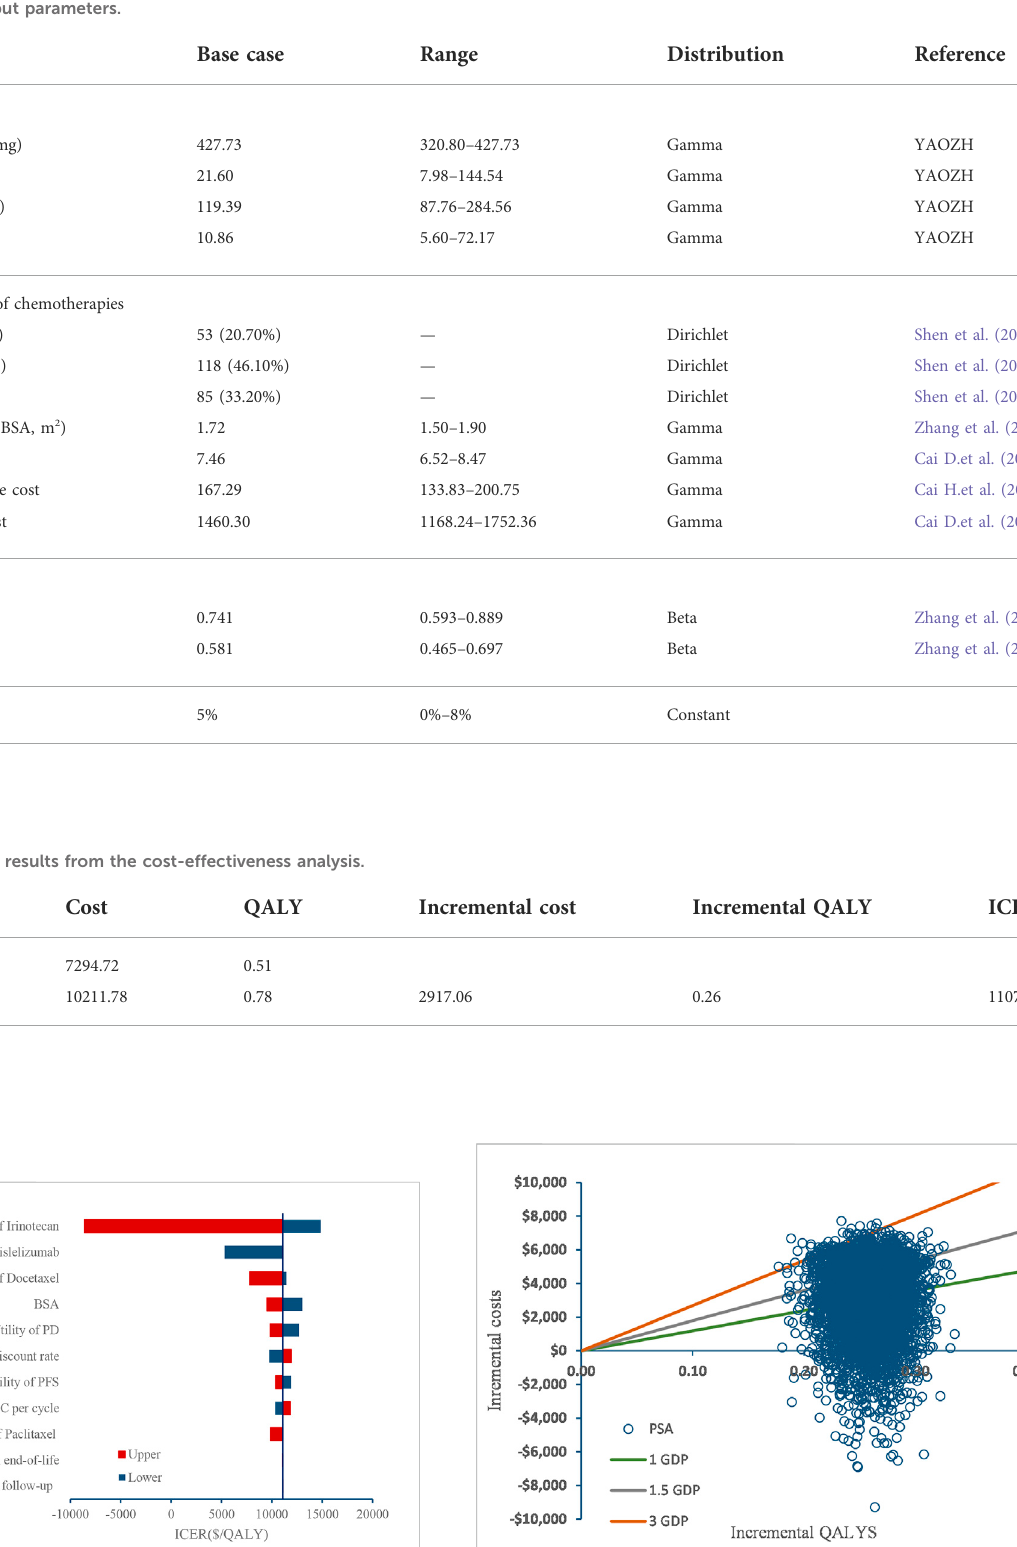
FIGURE 2 Tornado diagram.